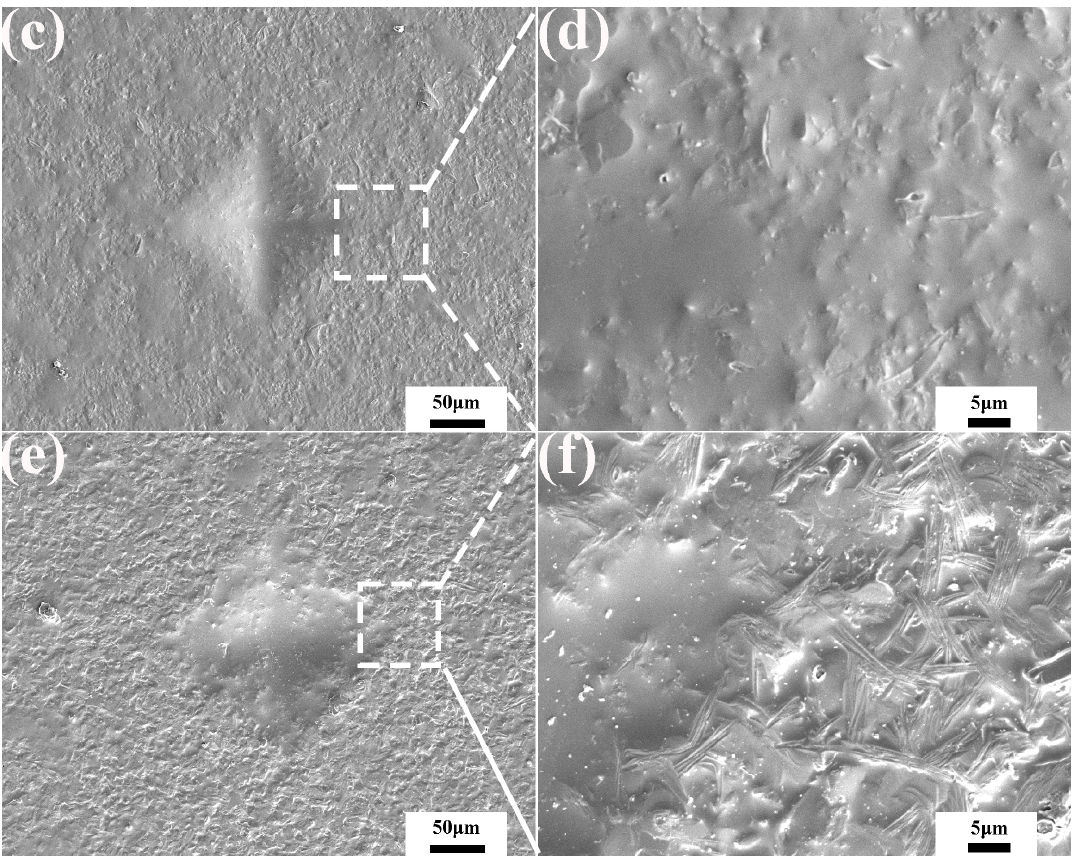
Figure 3. SEM morphology of Vickers indentation and cracks after healing at ( a , b ) 600 °C, ( c , d ) 700 °C and ( e , f ) 800 °C for 60 min.